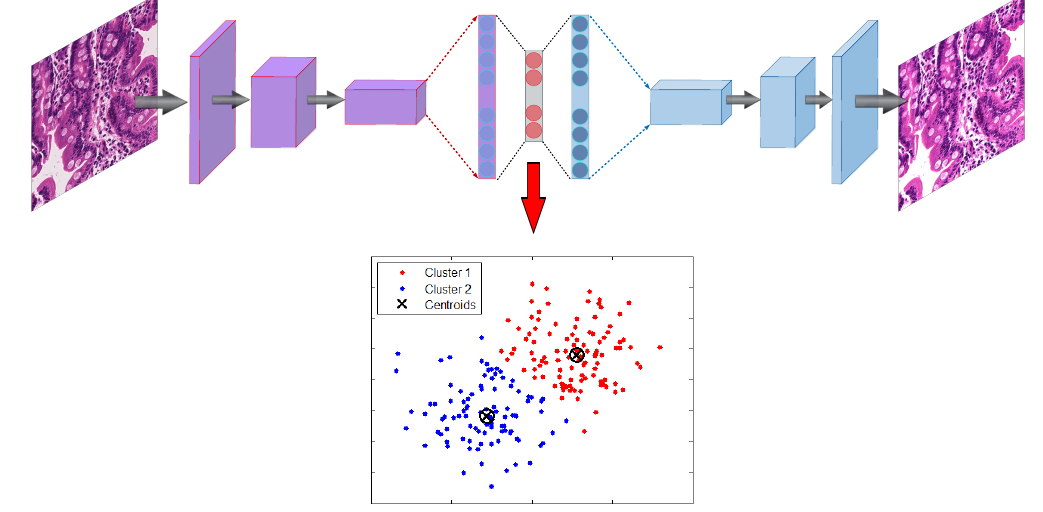
Figure 3. Example autoencoder architecture with K-means applied on the bottle-neck layer feature vector to cluster useful and not useful